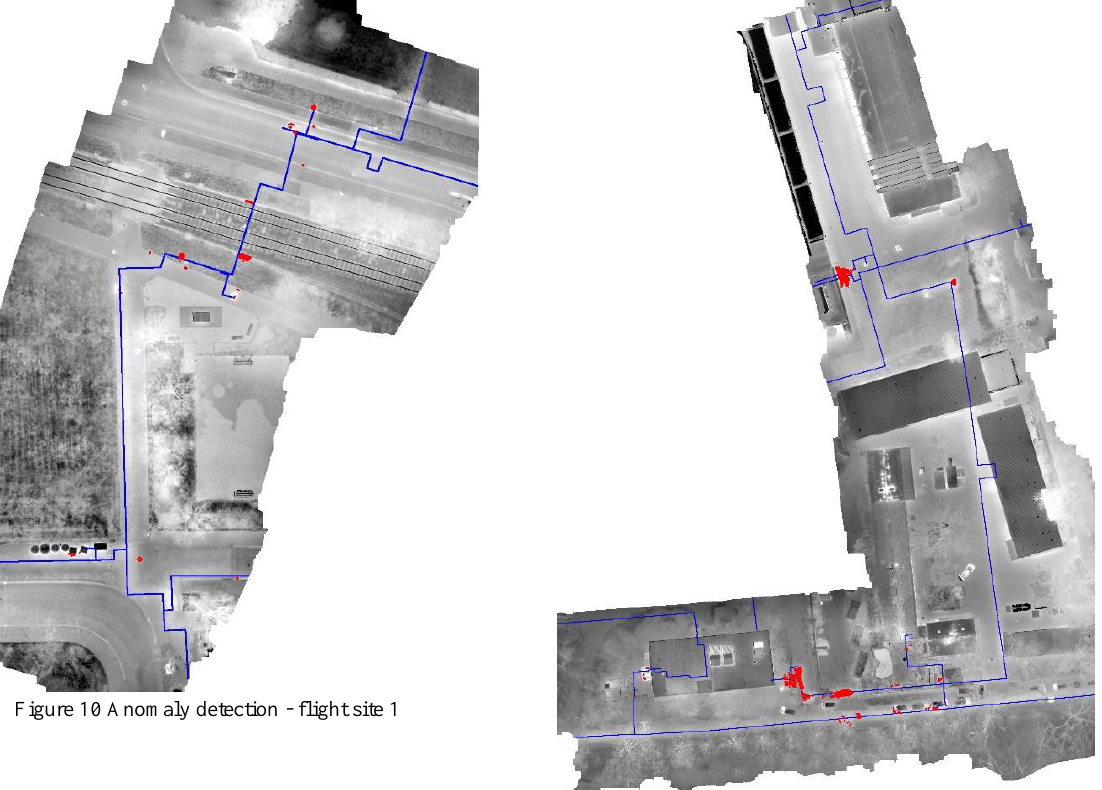
Figure 11 Anomaly detection - flight site 2